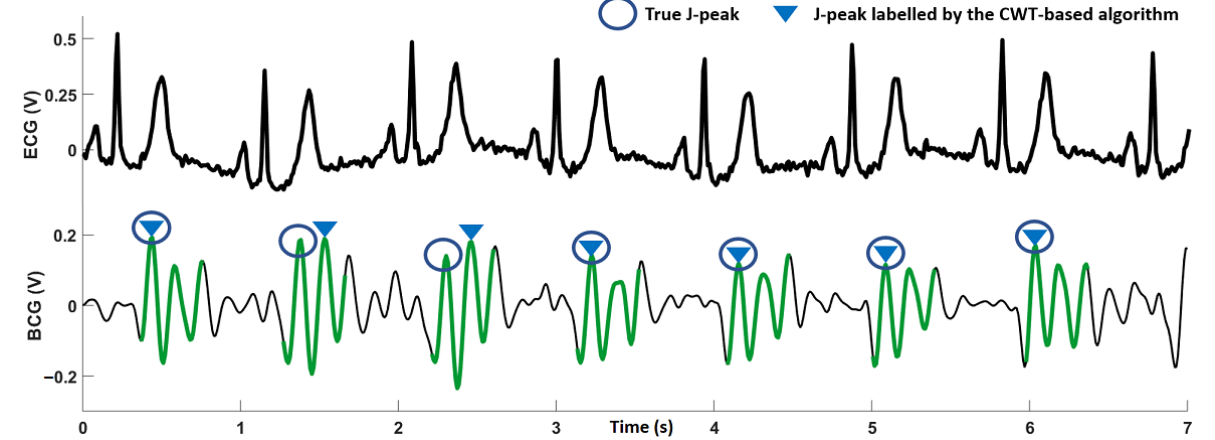
Figure 8. Seven seconds of electrocardiography and ballistocardiography recordings for participant 20. The signal visually appears to be of good quality, but J-peaks amplitudes are not significantly greater than the signal around them, causing the algorithm to label some J-peaks incorrectly. BCG: ballistocardiography; CWT: continuous wavelet transform; ECG: electrocardiography.